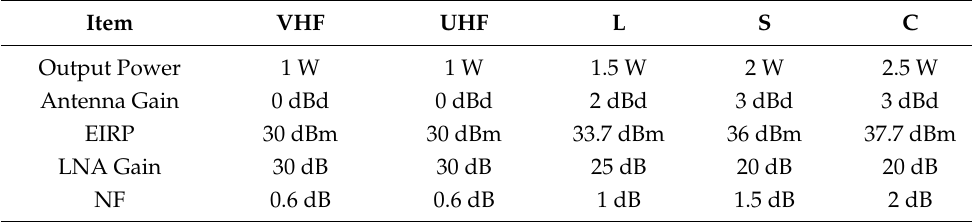
Figure 7. DCS equipment design: ( a ) SDR equipment; ( b ) Antenna design.